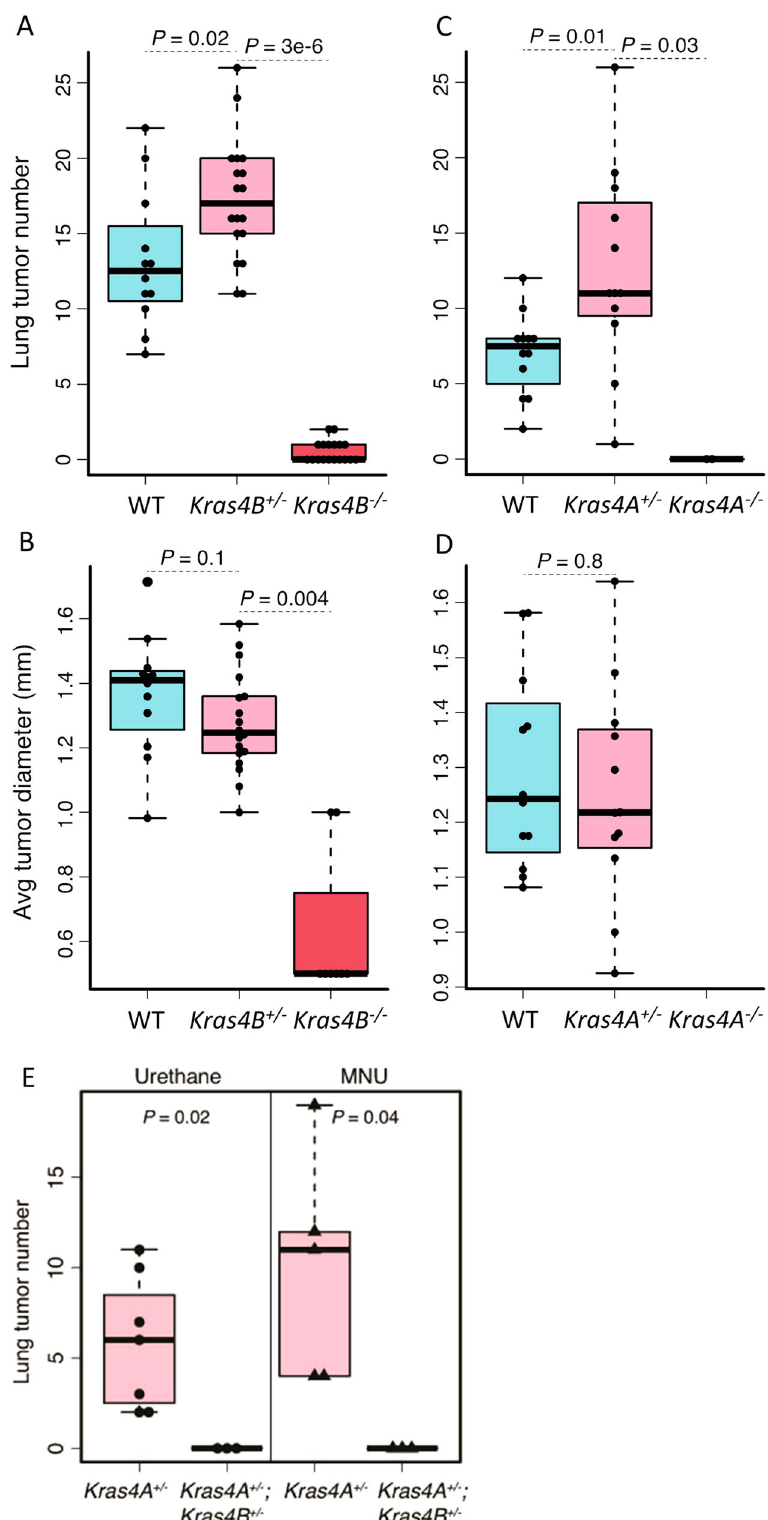
Subcutaneously injected knockout cells in nude mice also had impaired tumor forming capacity compared to the parental SUIT2 or A549 cells (Fig. 2E). Taken together, these data indicate that KRAS4A and KRAS4B are both required for optimal growth of KRAS mutant lung and pancreatic tumor cells in vitro and in immunode fi cient mice, but the effects of Kras4A inhibition